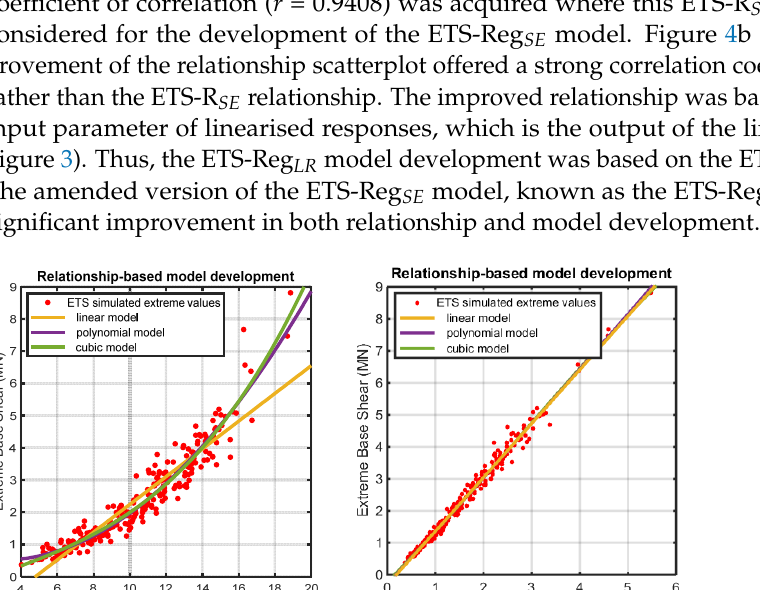
ETS-R LR relationship. For the cases of total quasi-static base shear responses, H s = 15 m, T z = 13.75 s,